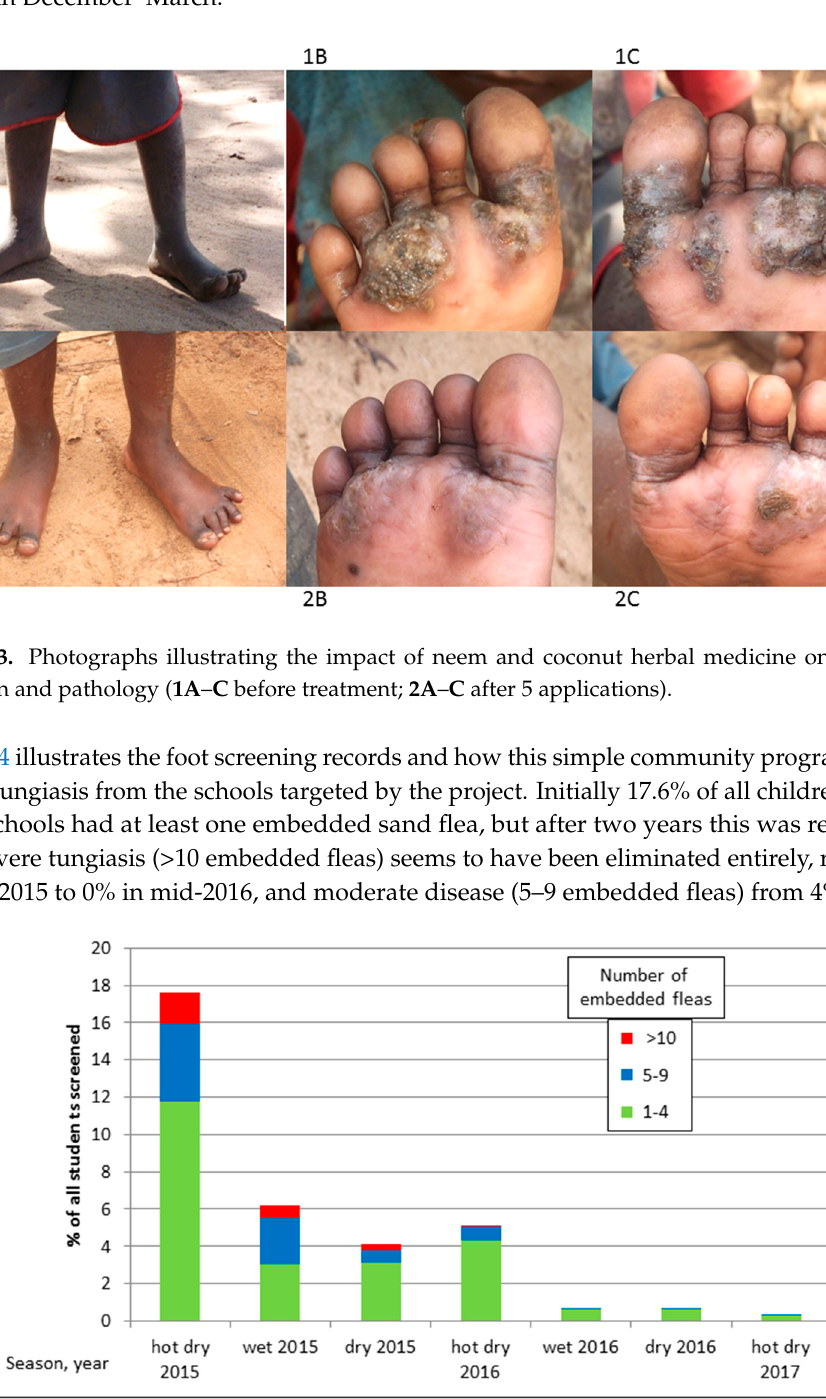
Figure 4. Period prevalence and intensity of tungiasis in target schools.